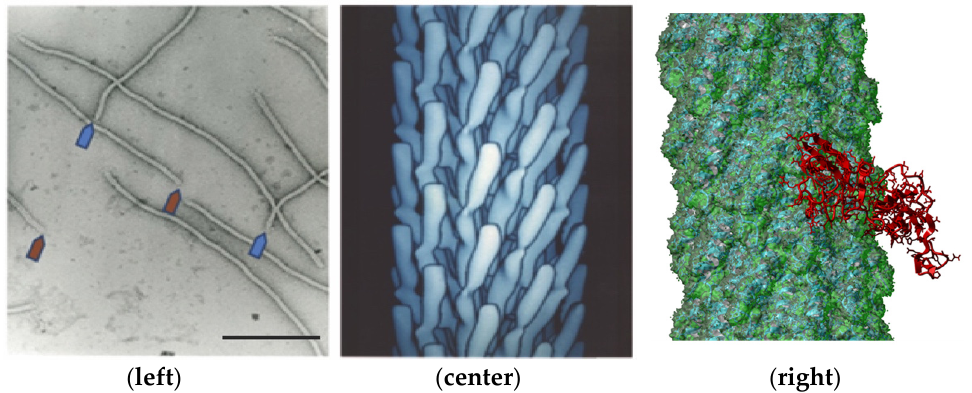
Figure 2. Electron microscopy image of filamentous phage ( left ) and electron density model ( center ) of filamentous phage M13 (courtesy of Lee Makowski and Gregory Kishchenko). Blue and red arrows depict the sharp and blunt ends of the phage capsid with attached minor coat proteins pIII/pIV and pVII/pIX, respectively (five copies each). Major coat protein (~2700 copies) forms the tubular capsid around viral single-stranded DNA (scale bar: 100 nm). 3D structure ( right ) of the complex between phage displaying the peptide EDYSELVSQ (green) with FGFR3 (red). Here, the peptide-displayed phages are designated by the structure of the inserted foreign peptides.